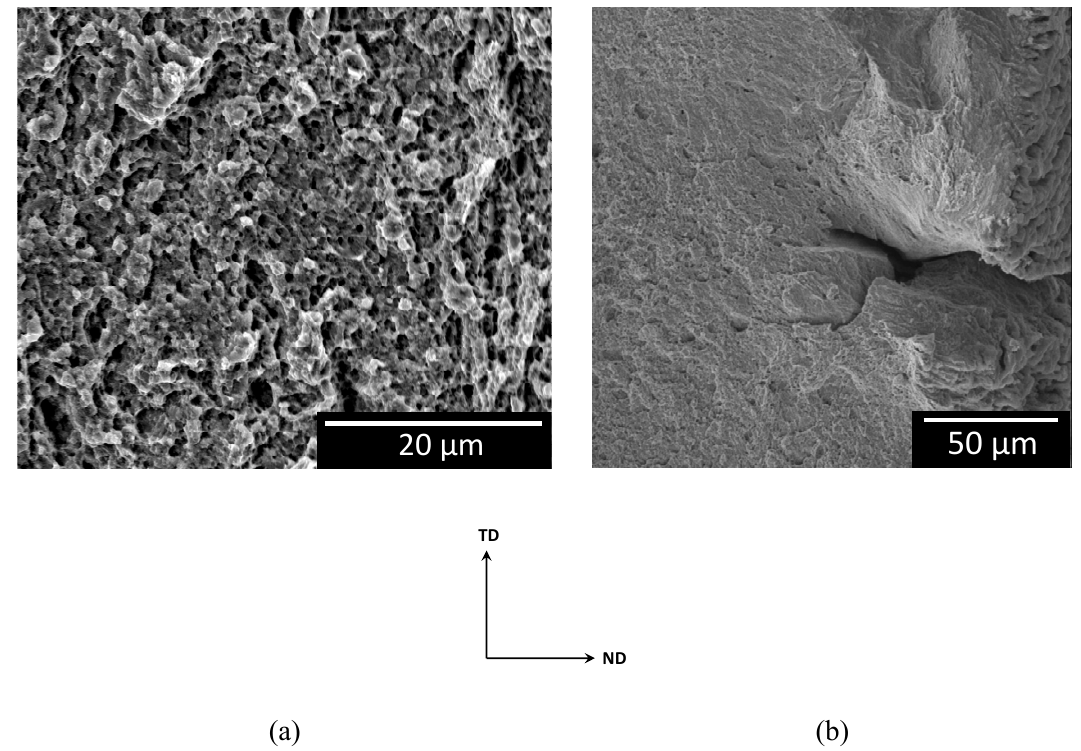
Figure 10. Representative secondary electron images of the fracture surface for FFA-coated NiCrMoV steel tested in 0.01 M acetic acid at 90 °C ( a ) ductile dimples, ( b ) more embrittled fracture surface showing stress-corrosion cracking at the edge of the sample.